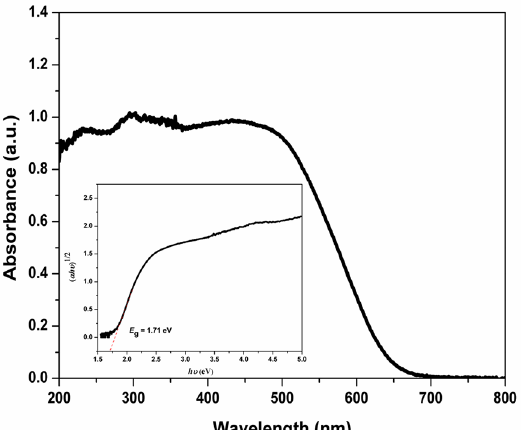
Figure 7. UV-vis diffuse reflectance spectroscopy of the BiOI hierarchical structure; inset in figure shows the plots of (αhν) 1/2 vs. photon energy (hν) for the BiOI hierarchical structure